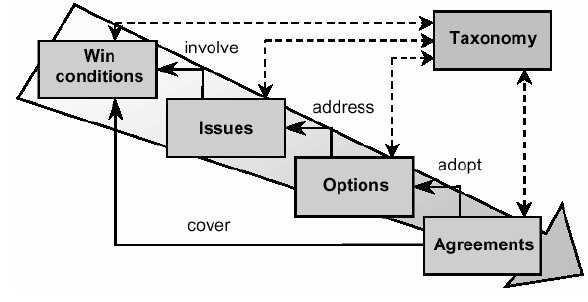
Figure 3. Win-Win negotiation